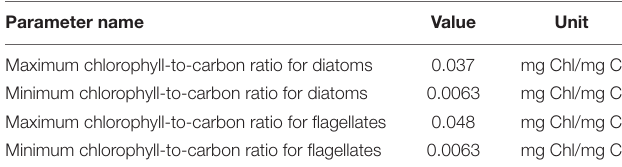
TABLE 1 | Parameters used in the flexible Chl/C-ratio formulation.